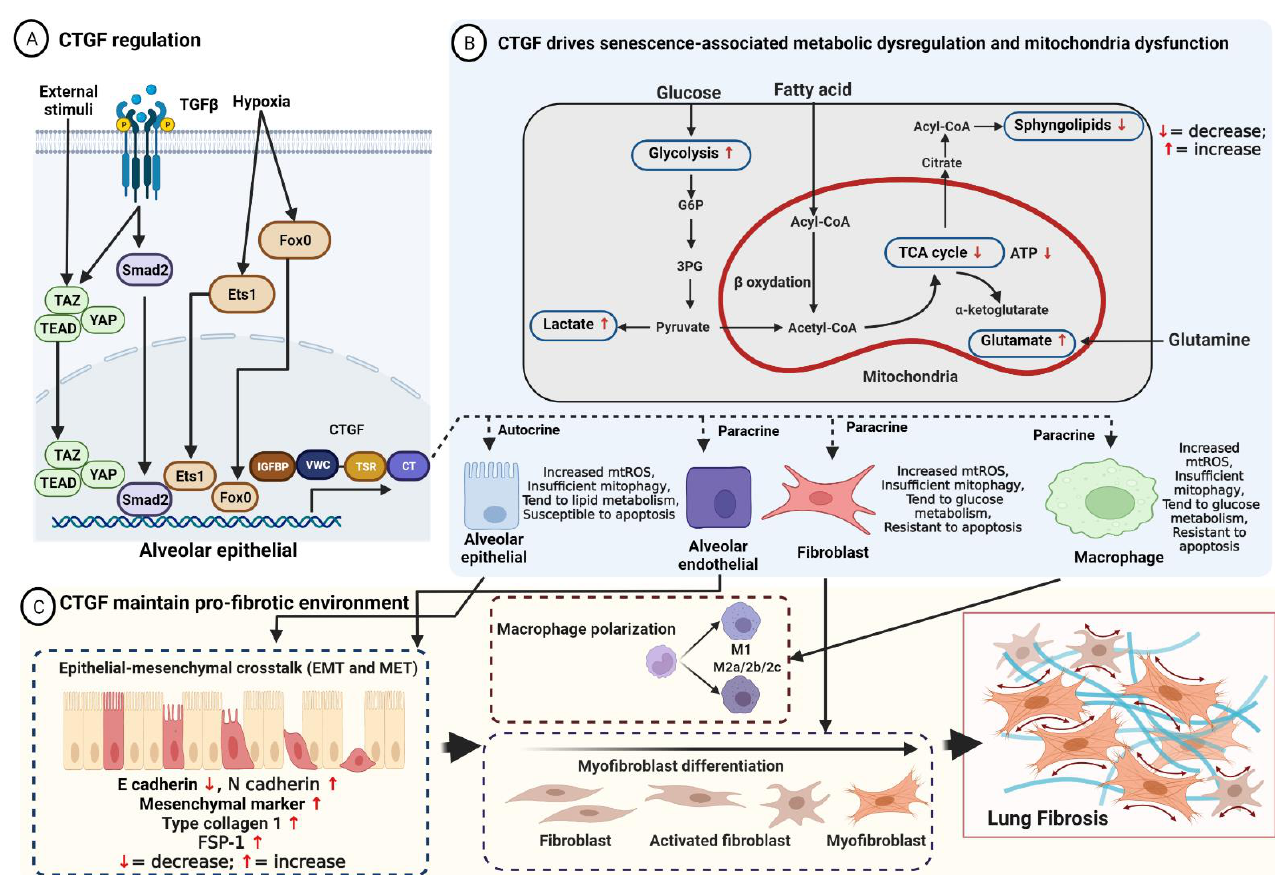
Figure 1. ( A ) Regulation of CTGF . CTGF expression is mainly regulated at the transcriptional level by various stimuli factors either directly or through cross-talk with cell surface receptors (TGF- β ) that induce signaling pathways that recruit transcription factors (YAP/TAZ/TEAD, SMAD2, Ets-1, PI3K-AKT, and Fox0) to the nucleus, inhibiting or stimulating the expression of CTGF; ( B ) CTGF regulates aberrant metabolic responses associated with senescence of alveolar epithelial cells, endo- thelial cells, fibroblasts, and alveolar macrophages. As an essential downstream mediator of TGF- 1-induced mitophagy, CTGF induces mtROS and increases glycolysis, lactate, and glutaminolysis, leading to apoptosis resistance in macrophages and fibroblasts. Conversely, accumulation of mtROS inhibits mitophagy to promote alveolar epithelial apoptosis; ( C ) CTGF maintains pro-fibrotic envi-